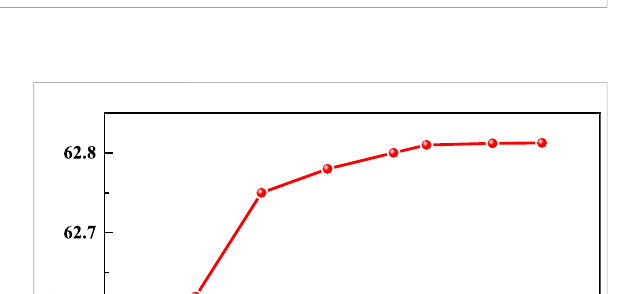
FIGURE 3 Meshes of the calculation domain.